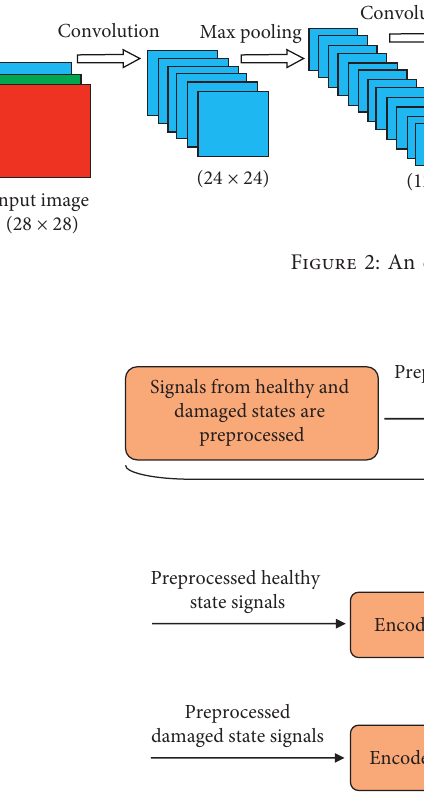
Figure 3: Procedure of the proposed damage detection method.